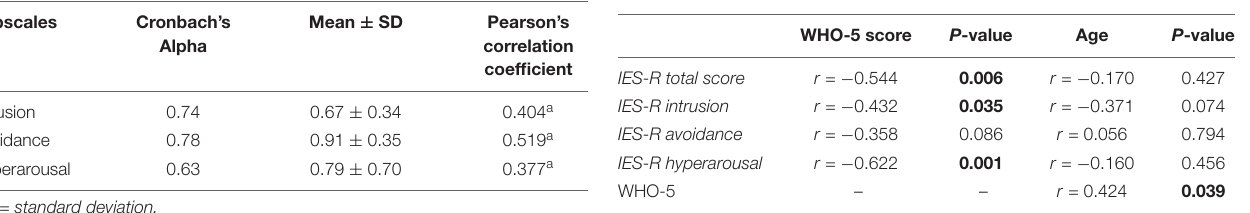
TABLE 4 | Correlation coefficients between WHO-5 and IES-R scores, including